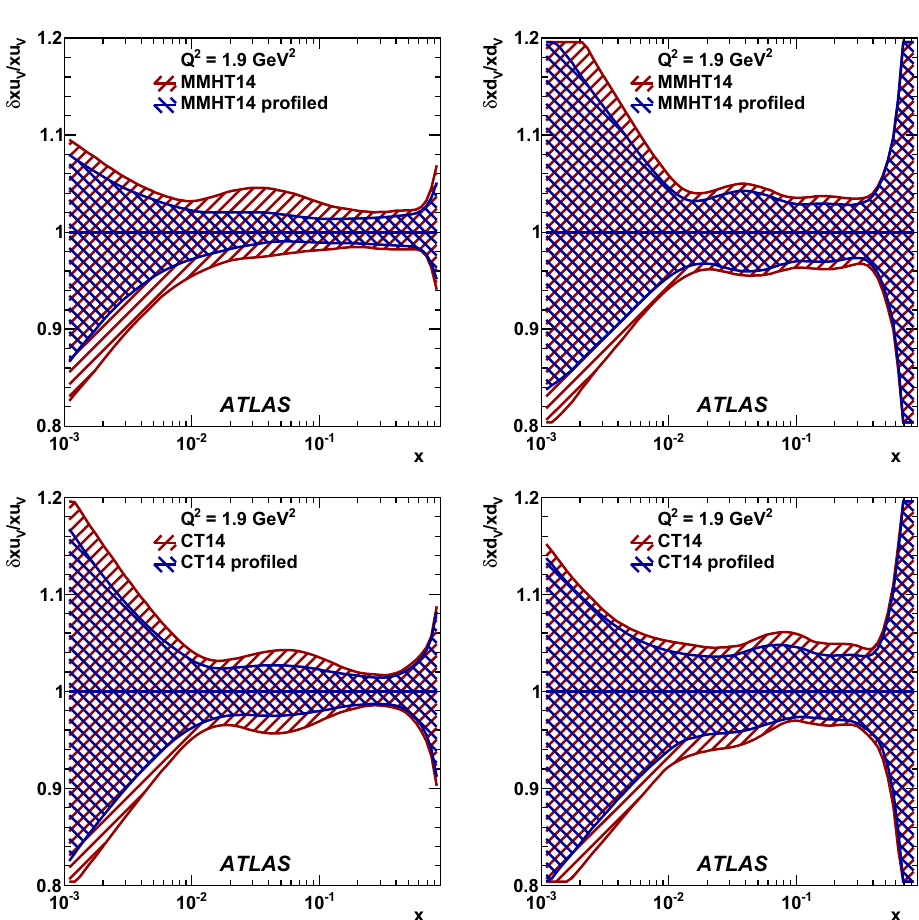
Fig. 27 Effect of profiling on the relative uncertainties of the valence up-quark distribution δ xu v ( x )/ xu v ( x ) ( left ) and the valence down- quark distribution δ xd v ( x )/ xd v ( x ) ( right ) as a function of Bjorken- x